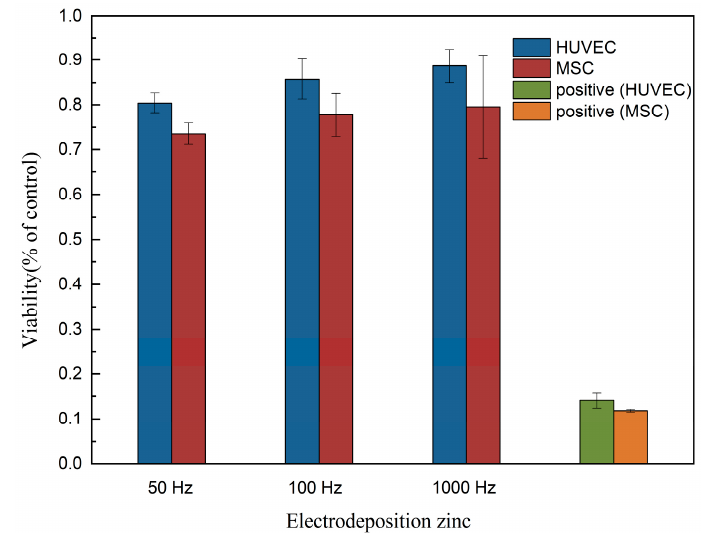
Figure 13. The cytotoxicity of electrodeposited zinc.